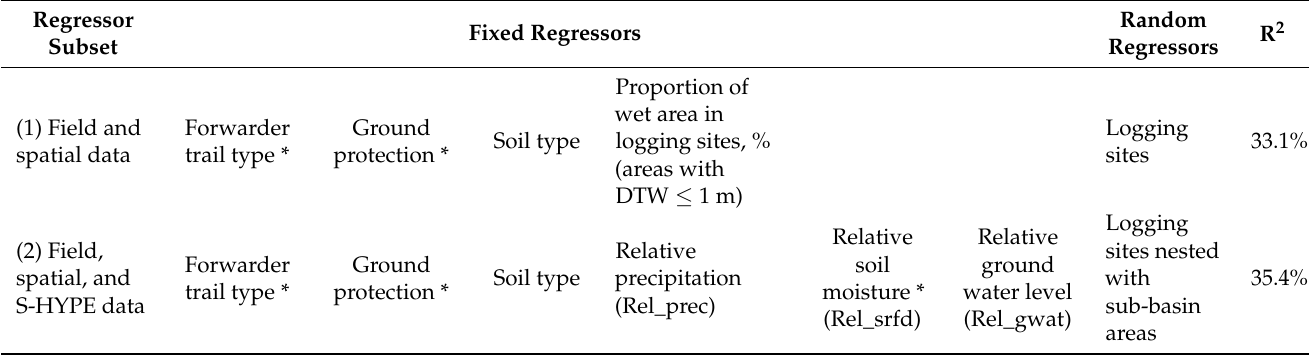
Table 3. Description of regressor subsets and models efficiency, R 2 , for inferring variation of forwarder trails with ruts across logging sites. Regressors marked with (*) were identified as significant at p < 0.05